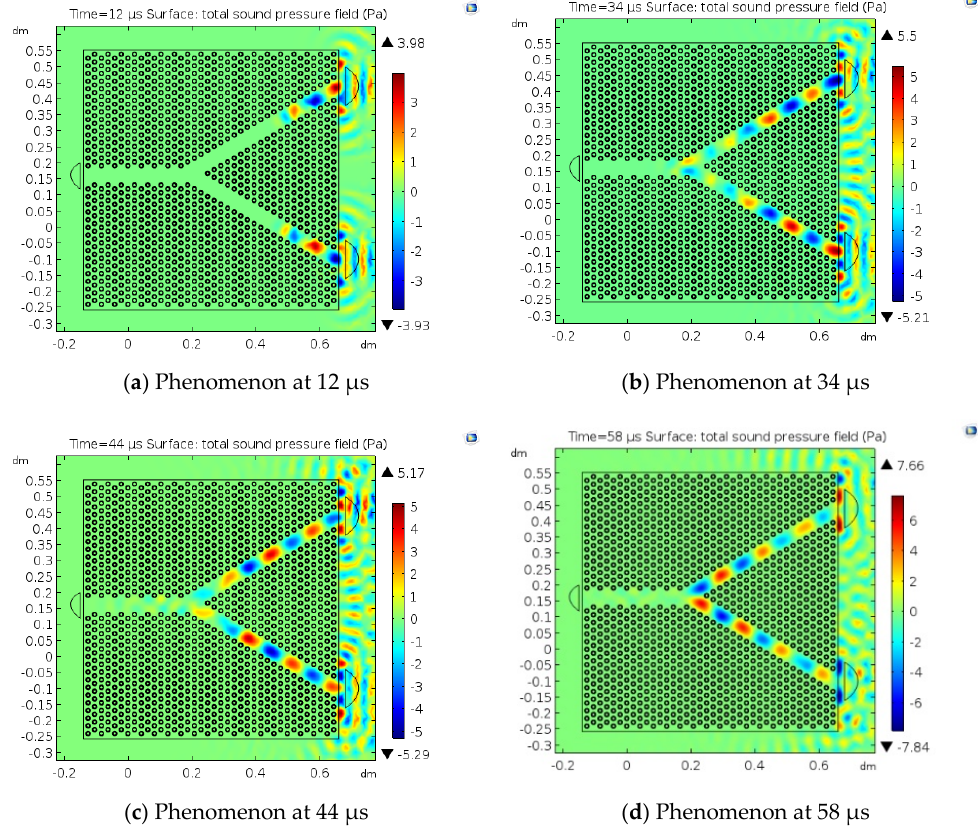
Figure 7. Acoustic phase interference simulation diagram: ( a ) Phenomenon at 12 µs; ( b ) phenomenon at 34 µs; ( c ) phenomenon at 44 µs; ( d ) phenomenon at 58 µs.